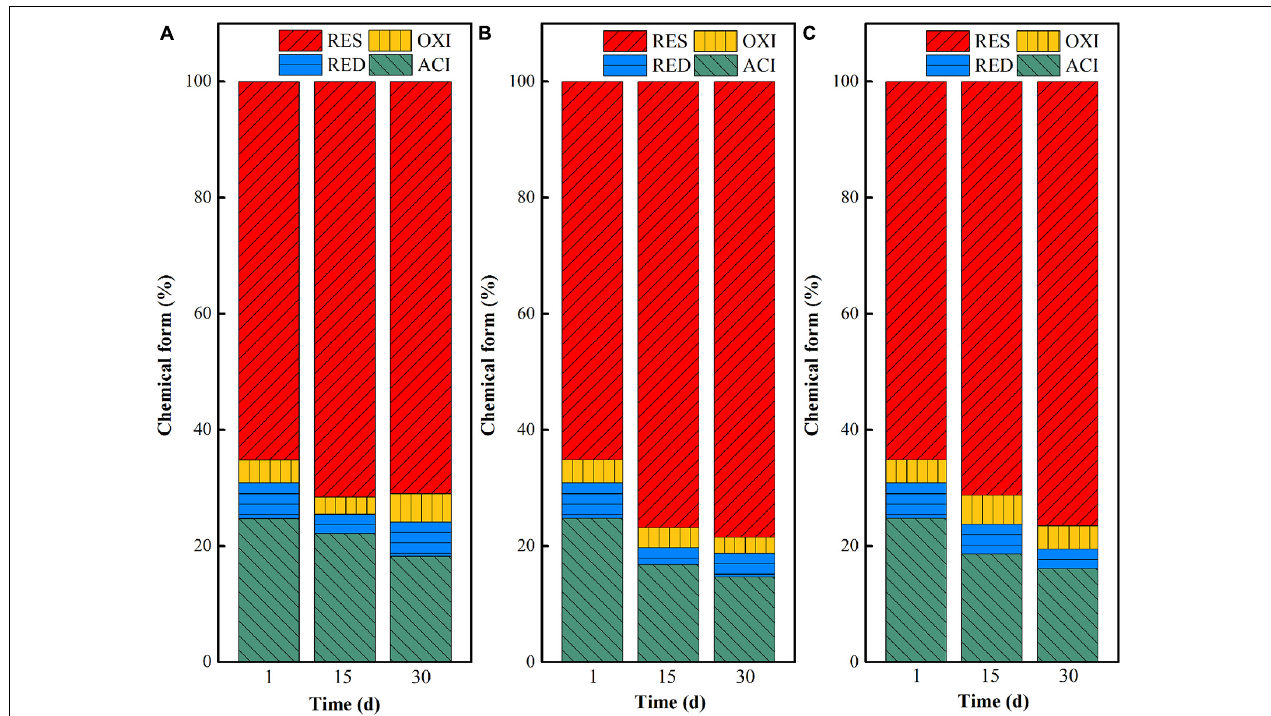
FIGURE 5 | Chemical form changes of uranium in uranium tailings under different temperatures: (A) T-15; (B) T-25; an d (C) T-35.